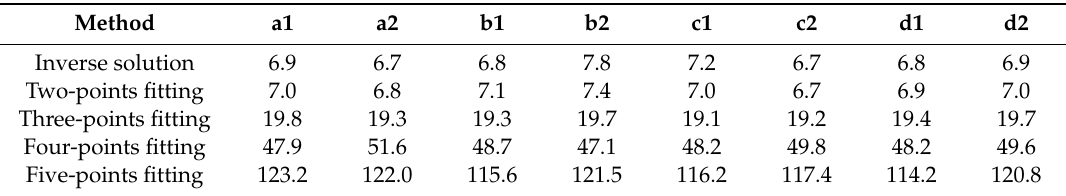
Table 4. The computation times (s) of the absolute Boltzmann entropy calculated using different methods for eight DEMs.